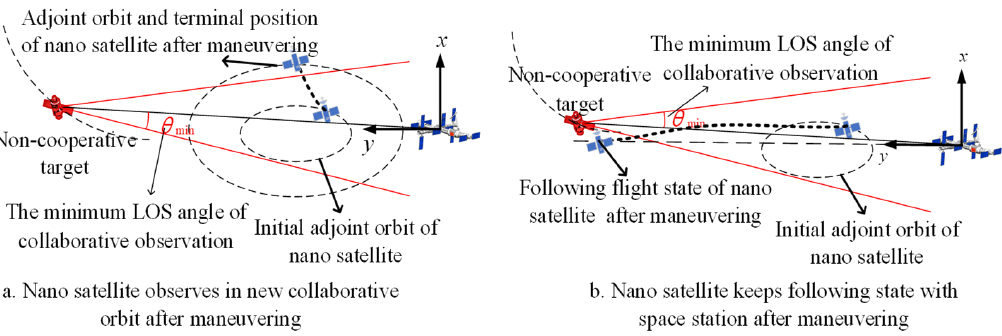
Figure 4. Scenario 1: Nano-satellite is on natural adjoint orbit at the initial time and all positions of the initial orbit do not satisfy the constraint of the minimum LOS angle.